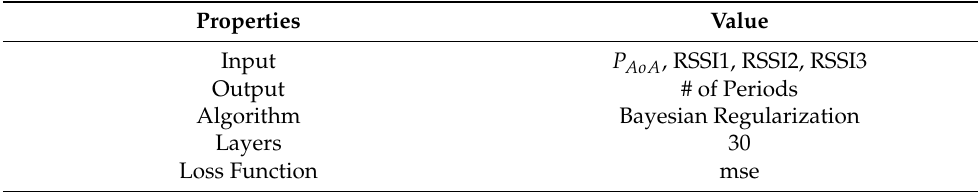
Table 2. Properties of ANN.